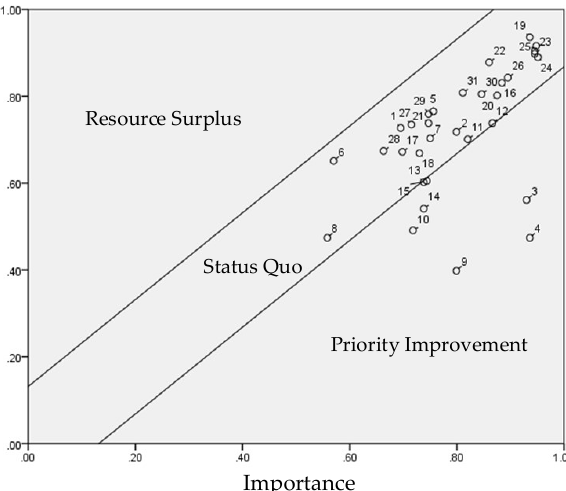
Figure 7. Performance Evaluation Matrix (PEM) of Respondents Younger than 70.